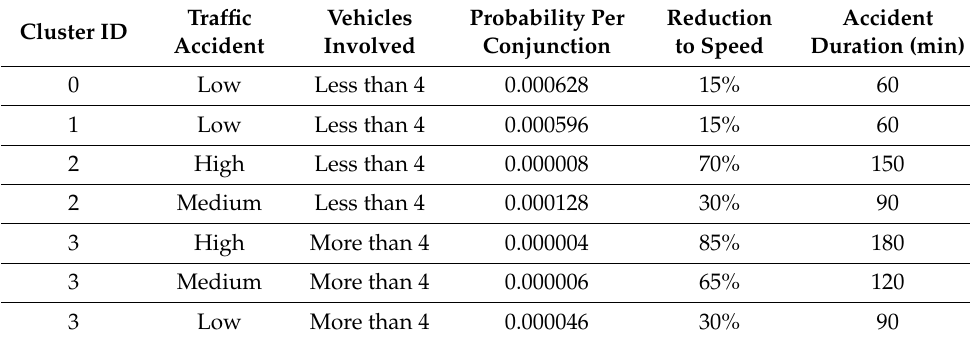
Table 3. The level of traffic